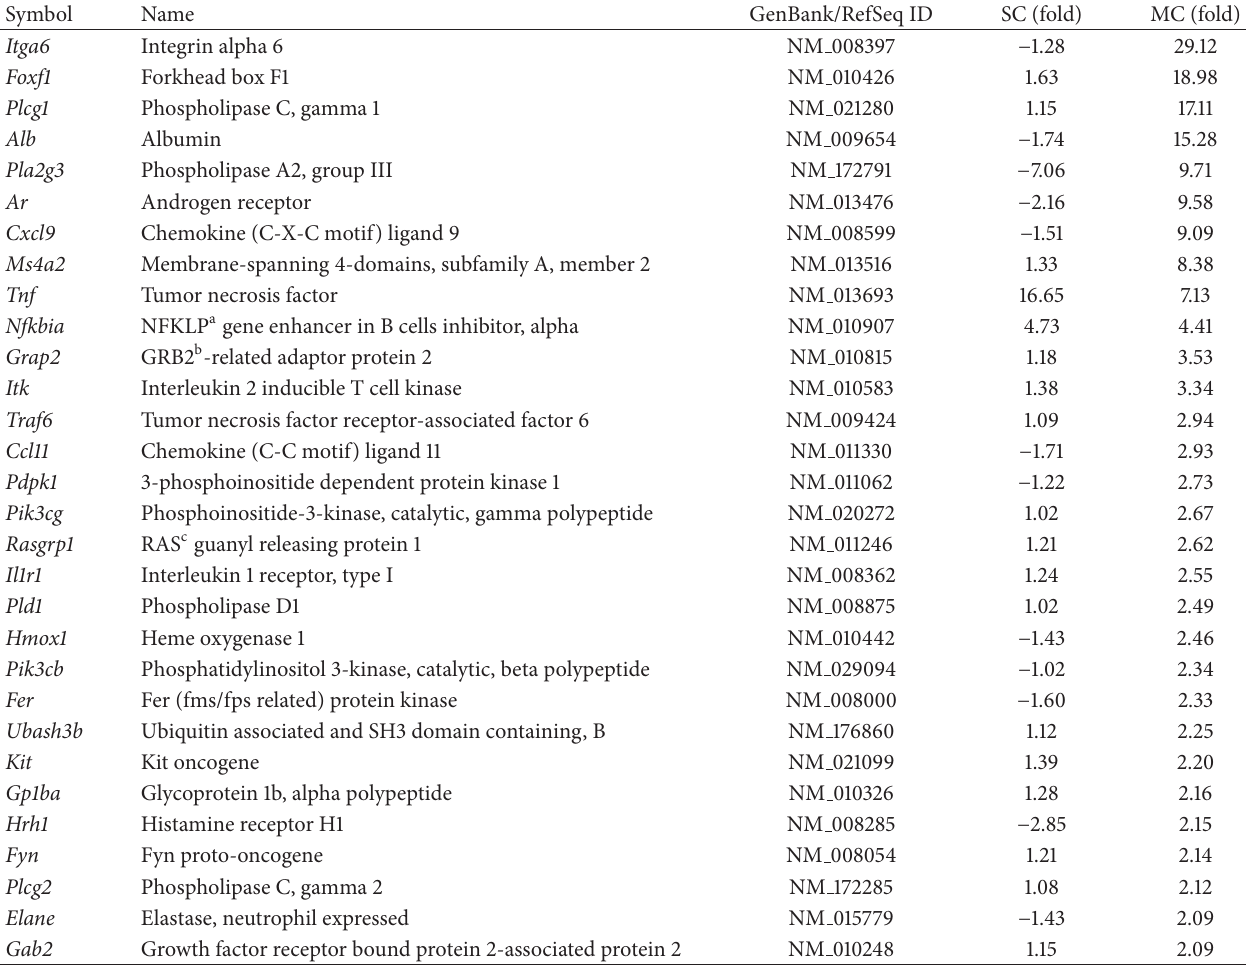
Table 1: OGG1-BER induced expression of genes involved in mast cell